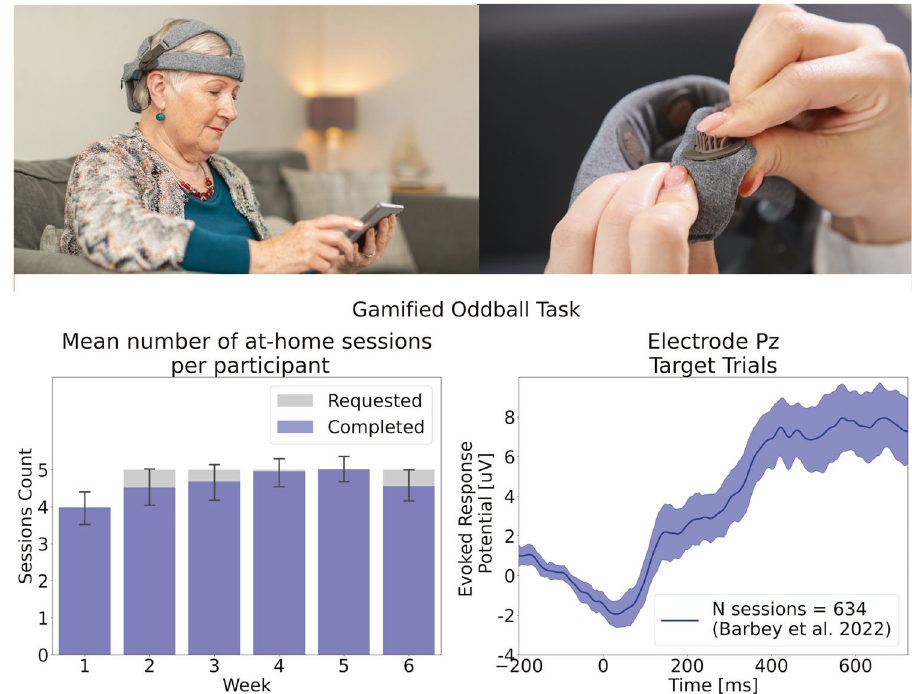
Fig. 3 Example of a portable, dry EEG platform. Upper left panel: The platform (Cumulus Neuroscience) consists of a wireless 16-channel dry sensor EEG headset linked to an Android tablet for task presentation. Upper right panel: Flexible Ag/AgCl coated dry EEG electrodes. Lower left panel: Figure adapted with permission from ref. [155] showing weekly adherence of a cohort of 50 healthy older adults ( + 55 years old) with a 6-week at-home EEG recording protocol. Lower Right Panel: Figure adapted with permission from ref. [153] showing averaged event- related potentials from target trials extracted from a gami fi ed Oddball task, collected remotely by participants